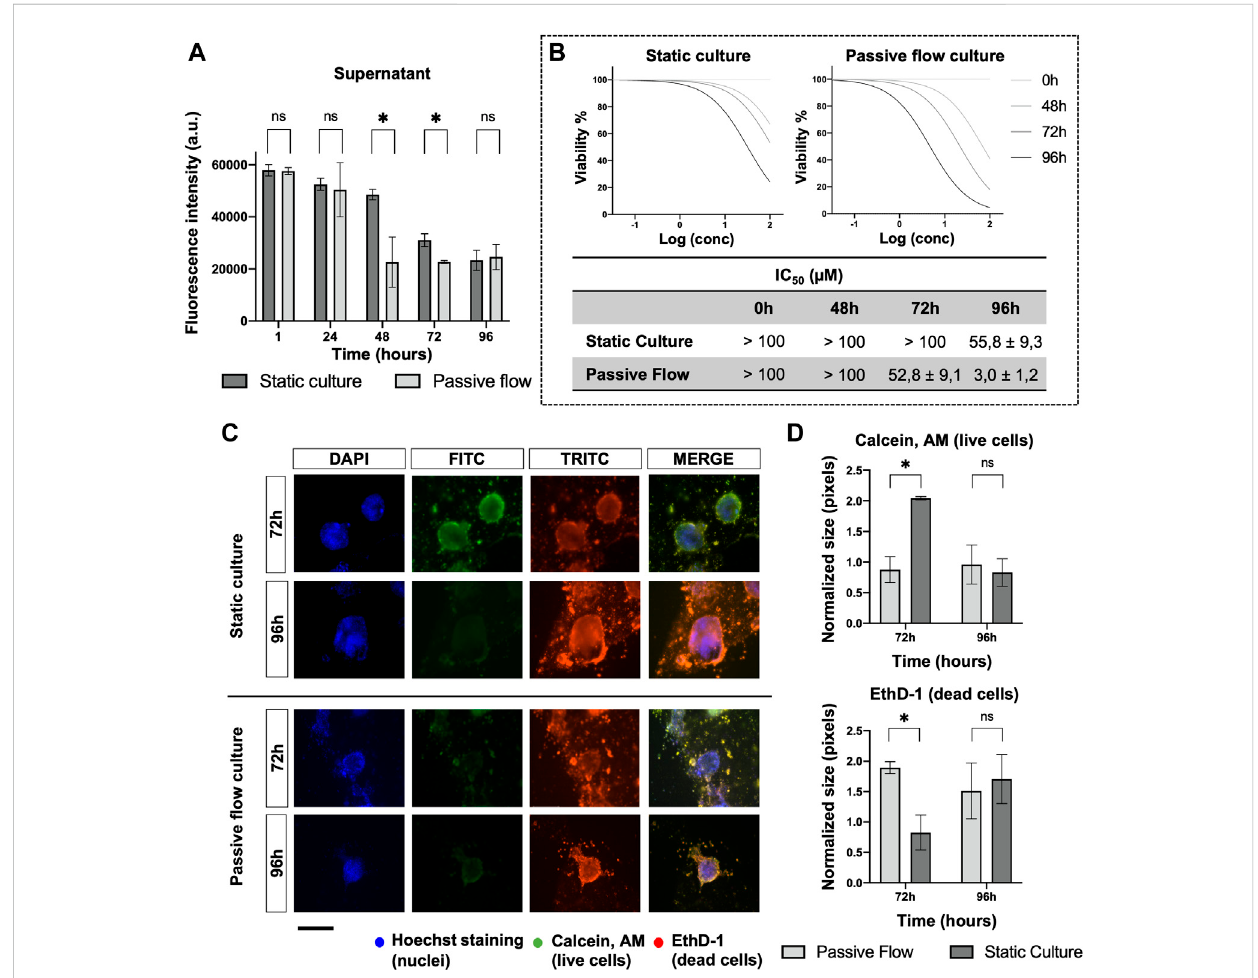
FIGURE 8 Drug penetration and organoids viability. (A) The amount of FITC labeled Paclitaxel is measured (in static and dynamic conditions) over time in the supernatant after 1, 24, 48, 72, and 96 h from the treatment. Mean ± SD is reported, and the p -value was calculated using a two-tailed Student ’ s t -test. * p ≤ 0.05,** p ≤ 0.01,*** p ≤ 0.001,and**** p ≤ 0.0001. (B) Dose-responsecurvesoforganoidstreatedwithCarboplatin.Theviabilityhasbeencalculated at 0, 48, 72, and 96 h from the drug treatment with the PrestoBlue HS Assay. The IC 50 Values ( μ M) of Carboplatin at different time points were obtained from four replicates. The numbers represent the mean and standard deviation. (C) Fluorescence microscopy images of organoids labeled with Hoescht 33,342, Calcein, AM, and EthD-1. The nuclei of the cells are shown in blue, the live cells are shown in green, dead cells are shown in red. A comparison at 72 and 96 h between static cultures and passive fl ow cultures is shown. Scalebar 250 μ m; (D) Quanti fi cation of fl uorescence signal: the number of red and green pixels was normalized by the number of blue pixels and mean ± SD is reported. The p -value was calculated using a